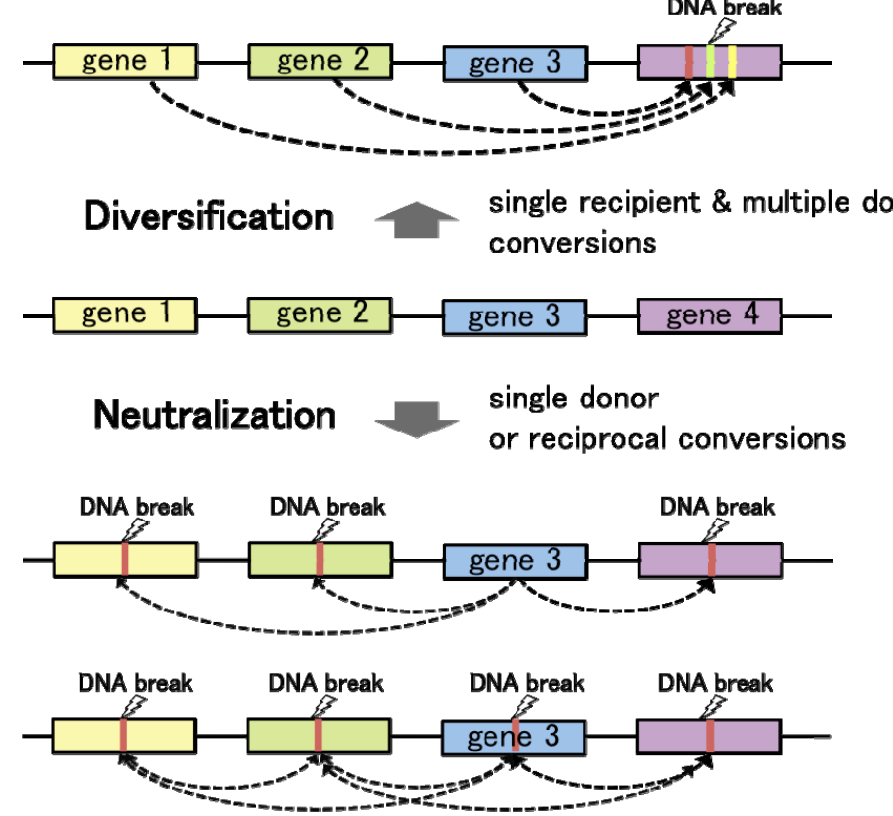
Figure 3. Regulation of genome alteration and integrity by gene conversion. The donor/recipient choice for gene conversion among homologous DNA sequences is determined by the localization of recombination-initiating DNA lesions, which are introduced under the influence of epigenetic marks such as histone acetylation, local chromatin structure, and transcriptional activity (shown as broken wavy lines). Gene conversion with a single template sequence neutralizes the divergence of the homologous DNA sequences. Adversely, the convergent gene conversion from multiple different DNA sequences results in diversification of the recipient